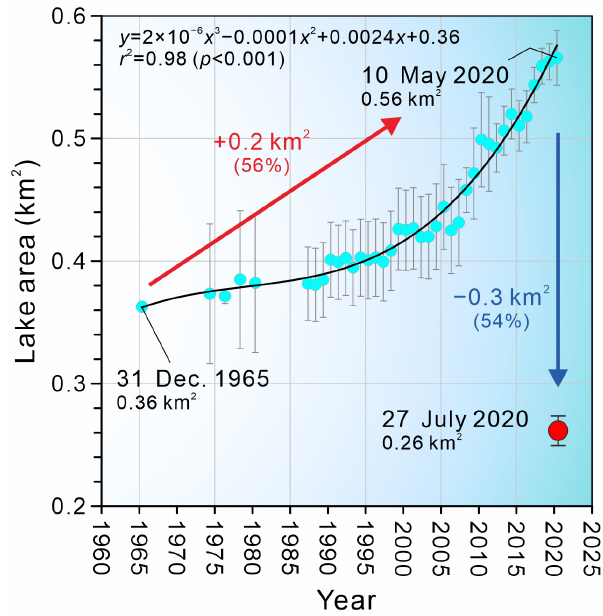
Figure 4. Inter-annual dynamics of Jinwuco during 1965–2020 (prior to the GLOF), and the abrupt decrease in lake area after the